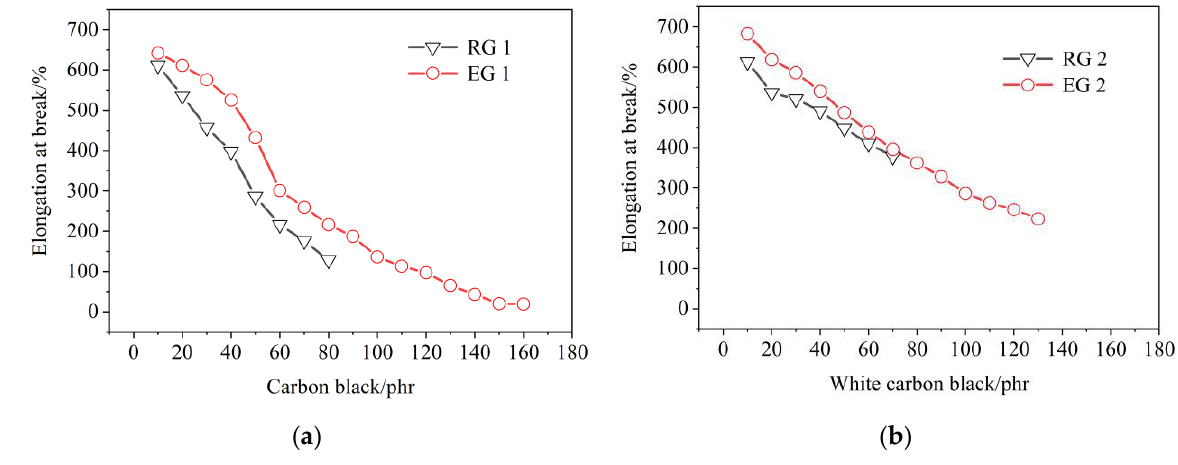
Figure 6. Effect of filler on the elongation at break of rubber samples. RG 1 and EG 1 were for SBR rubber mixtures; RG 2 and EG 2 were rubber mixtures based on NR rubber. ( a ) Effect of CB on the elongation at break of rubber samples; ( b ) Effect of WCB on the elongation at break of rubber samples.